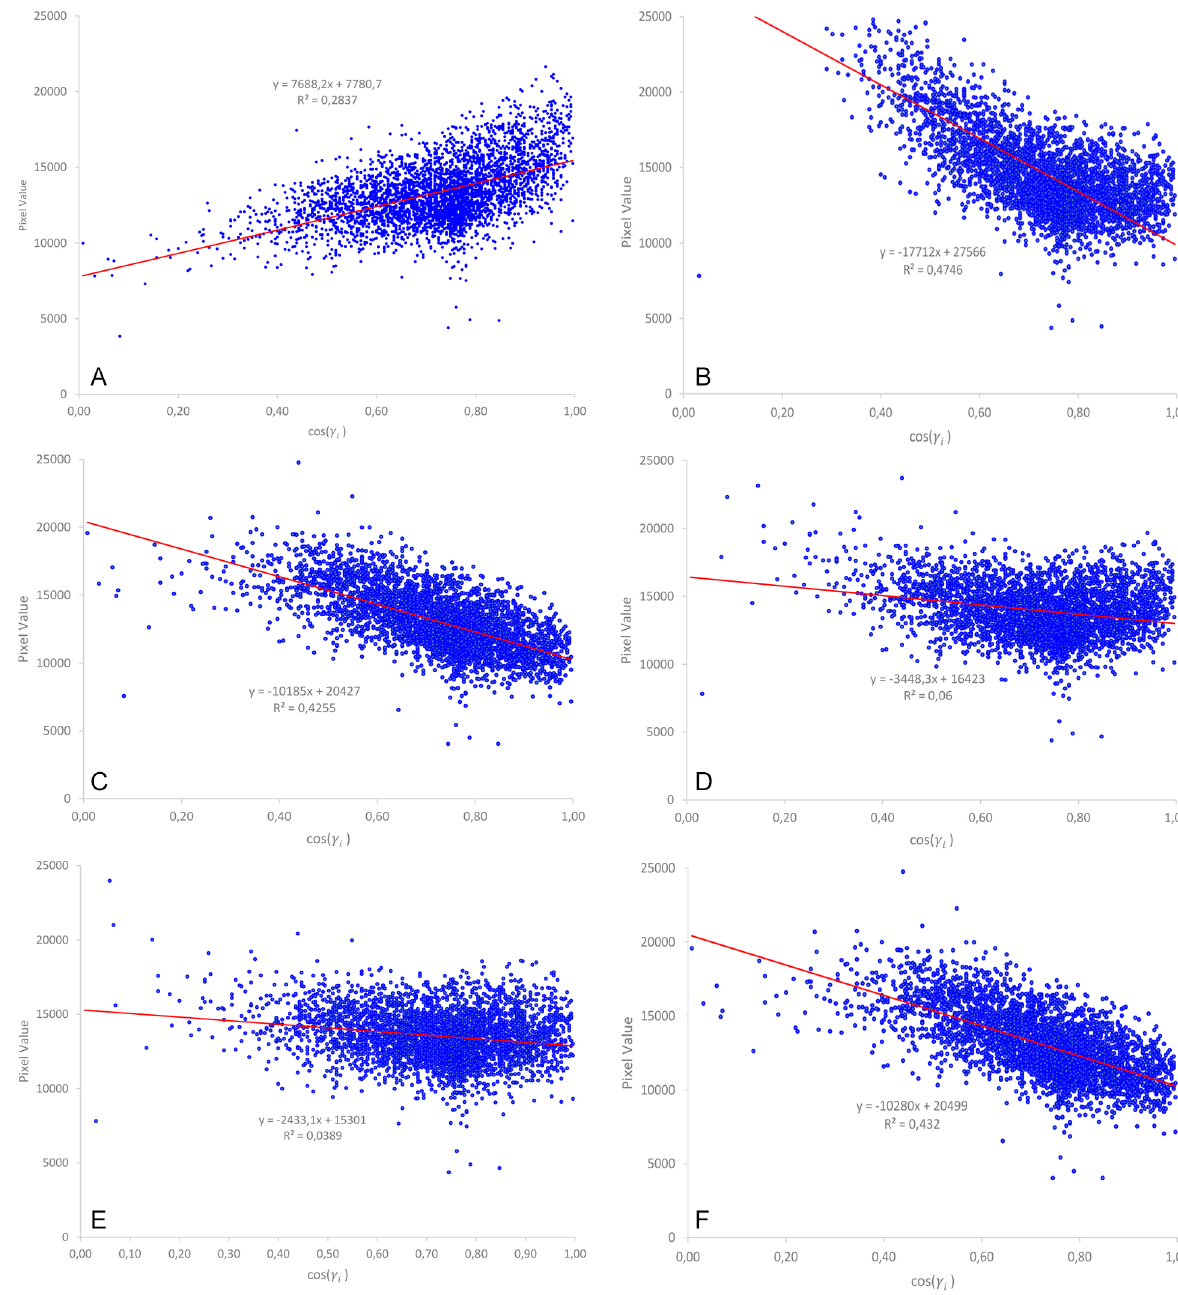
Fig. 5. Scatter plots and regression lines between the pixel value and local illumination (cos γ ) over Near- i infrared band for 3942 taken from both Precorrected (A) and corrected image using: B – cosine correction (Teillet et al. 1982), C – modified-cosine correction (Civco 1989), D – Minnaert correction (Minnaert 1941), E – modified Minnaert correction (Riaño et al. 2003), and F – two-stages normalization (Civco 1989) modified by (Law & Nichol